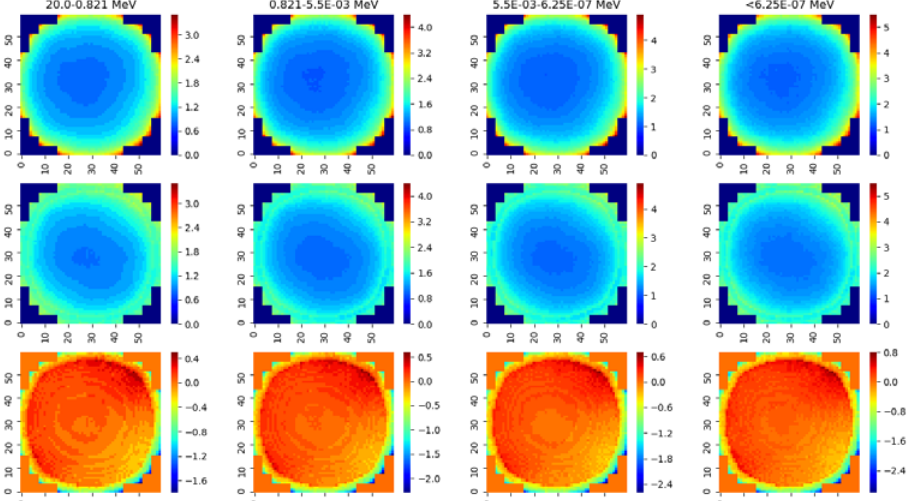
Figure 9. Comparison of Standard Deviations in the Benchmark Energy Group Scheme Standard MONK (top), with Importance Map (middle), Absolute Difference (bottom)